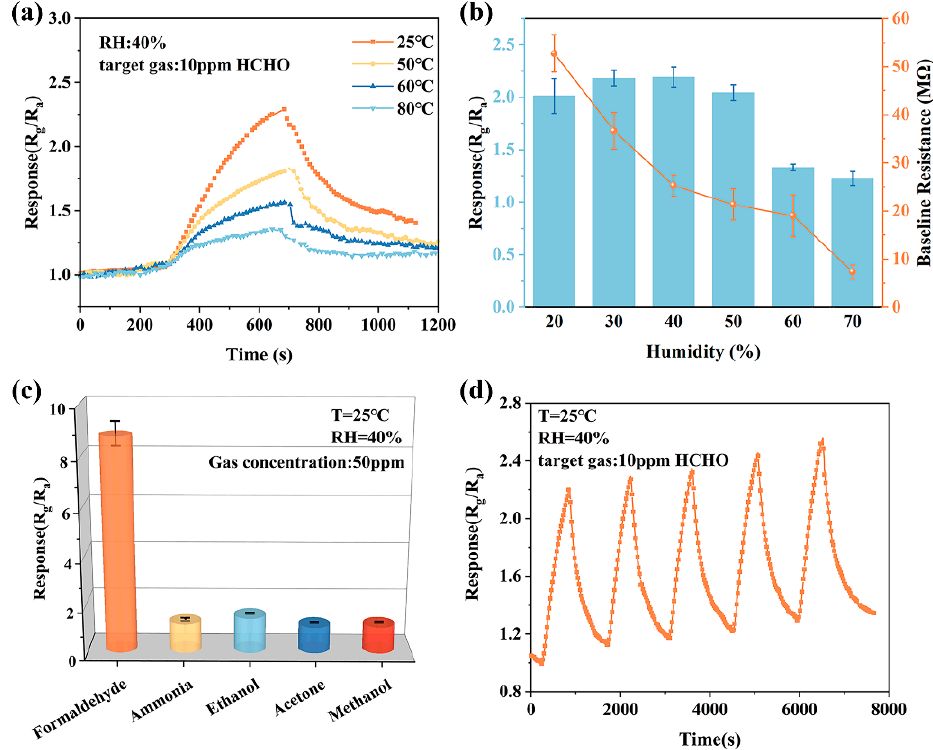
Figure 8. ( a ) The response of the MXene/NiO-P2 sensor to 10 ppm HCHO at different operating temperatures. ( b )The response values and baseline resistances of the MXene/NiO-P2 sensor at different humidities. ( c ) Selectivity of the MXene/NiO-P2 sensor to HCHO and other VOCs gases, such as ammonia, ethanol, acetone, and methanol, with a concentration of 50 ppm at 25 ◦ C. ( d ) The repeatability of the MXene/NiO-P2 sensor to 10 ppm HCHO during the five testing cycles at 25 ◦ C.